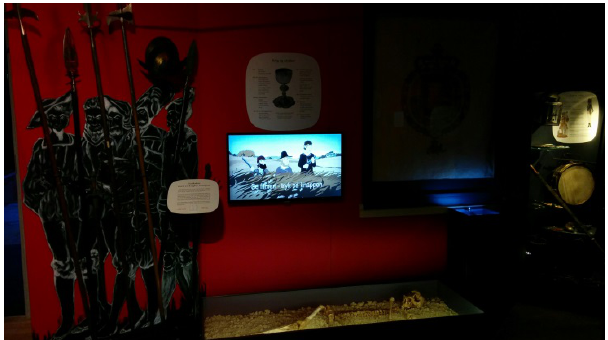
Figure 3. The animation on the screen is a narrative on its own. Around it are artefacts (for example the skeleton of one of the film’s main characters) connecting and adding depth to the audio-visual story. Viborg Museum, Denmark. Photo: The